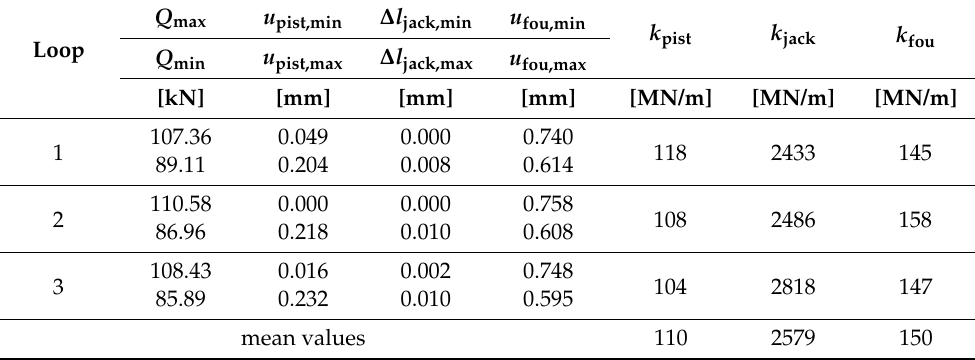
Table A1. Extreme values: Q , u pist , ∆ l jack and u fou determined from subsequent load cycles of the passive support during the in-situ tests and stiffness of the support elements k pist , k jack , k fou determined on their basis.